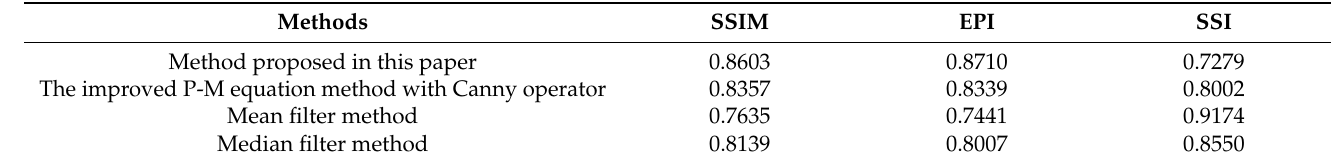
Table 2. SSIM, EPI and SSI calculation results of reconstructed phase after processing Figure 4d with different speckle suppression